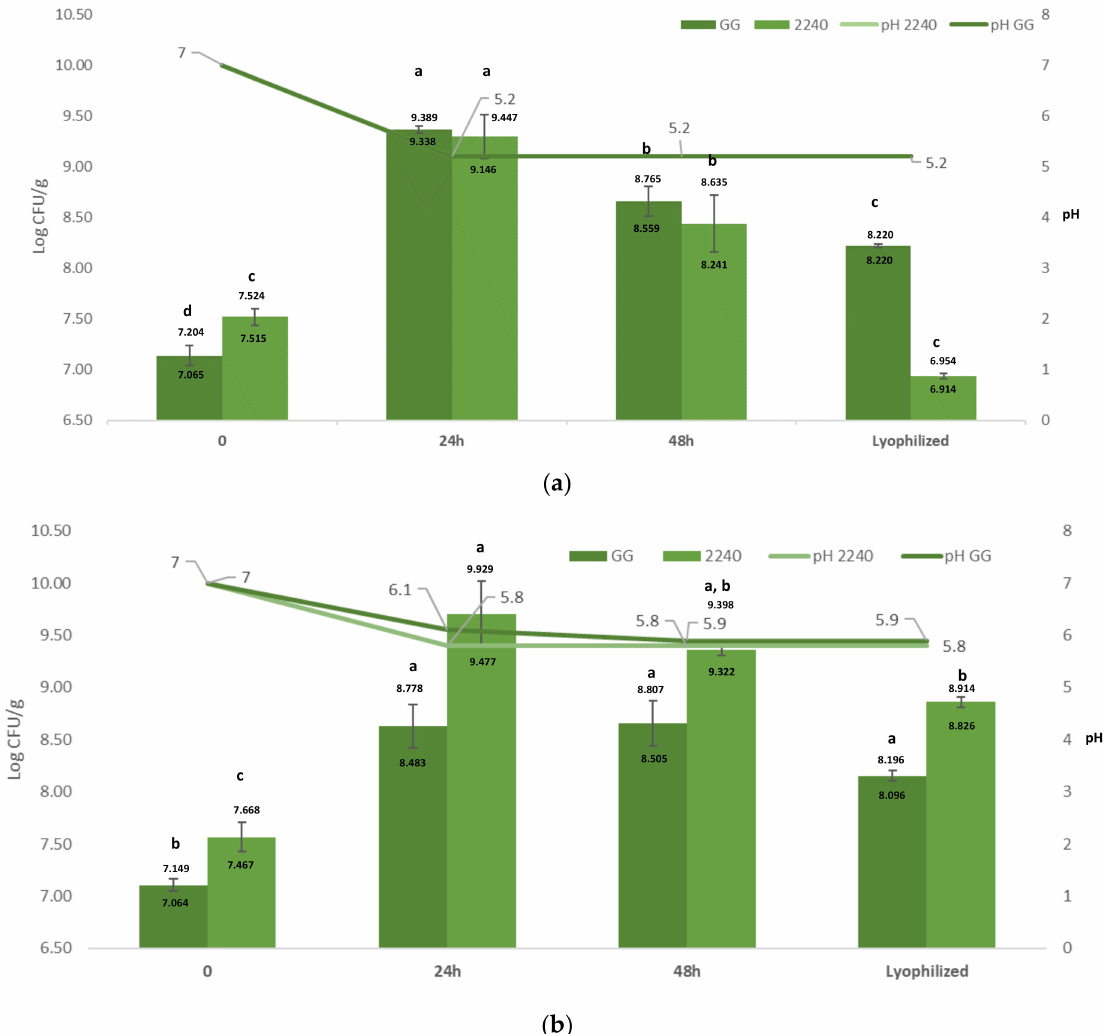
Figure 1. Lactic acid bacteria (LAB) growth (log CFU/g) and pH values in Arthrospira platensis biomass after 24 and 48 h of fermentation at 37 ◦ C for Lacticaseibacillus rhamnosus GG (GG) and Lacticaseibacillus casei 2240 (2240) bacteria: ( a ) UV-treated samples; ( b ) heat-treated samples. Data are represented as average ± SD (bars); two replicates for each sample were measured. Letters indicate significant differences ( p <